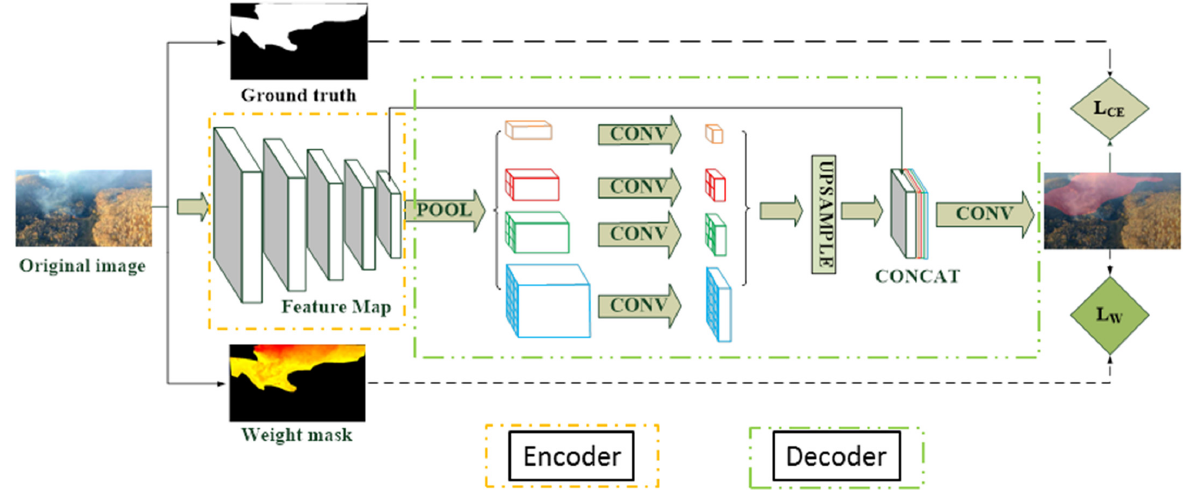
Figure 1. The main framework of the weighted method proposed in this paper 1 . 1 : The network is pre-existing deep learning semantic segmentation network, encoder is MobileNet [46] and decoder is PSPnet [47]. The network was initialized with the weights of the MobileNet network pre-trained on the ImageNet. The final optimization loss includes weighted loss and cross-entropy loss.